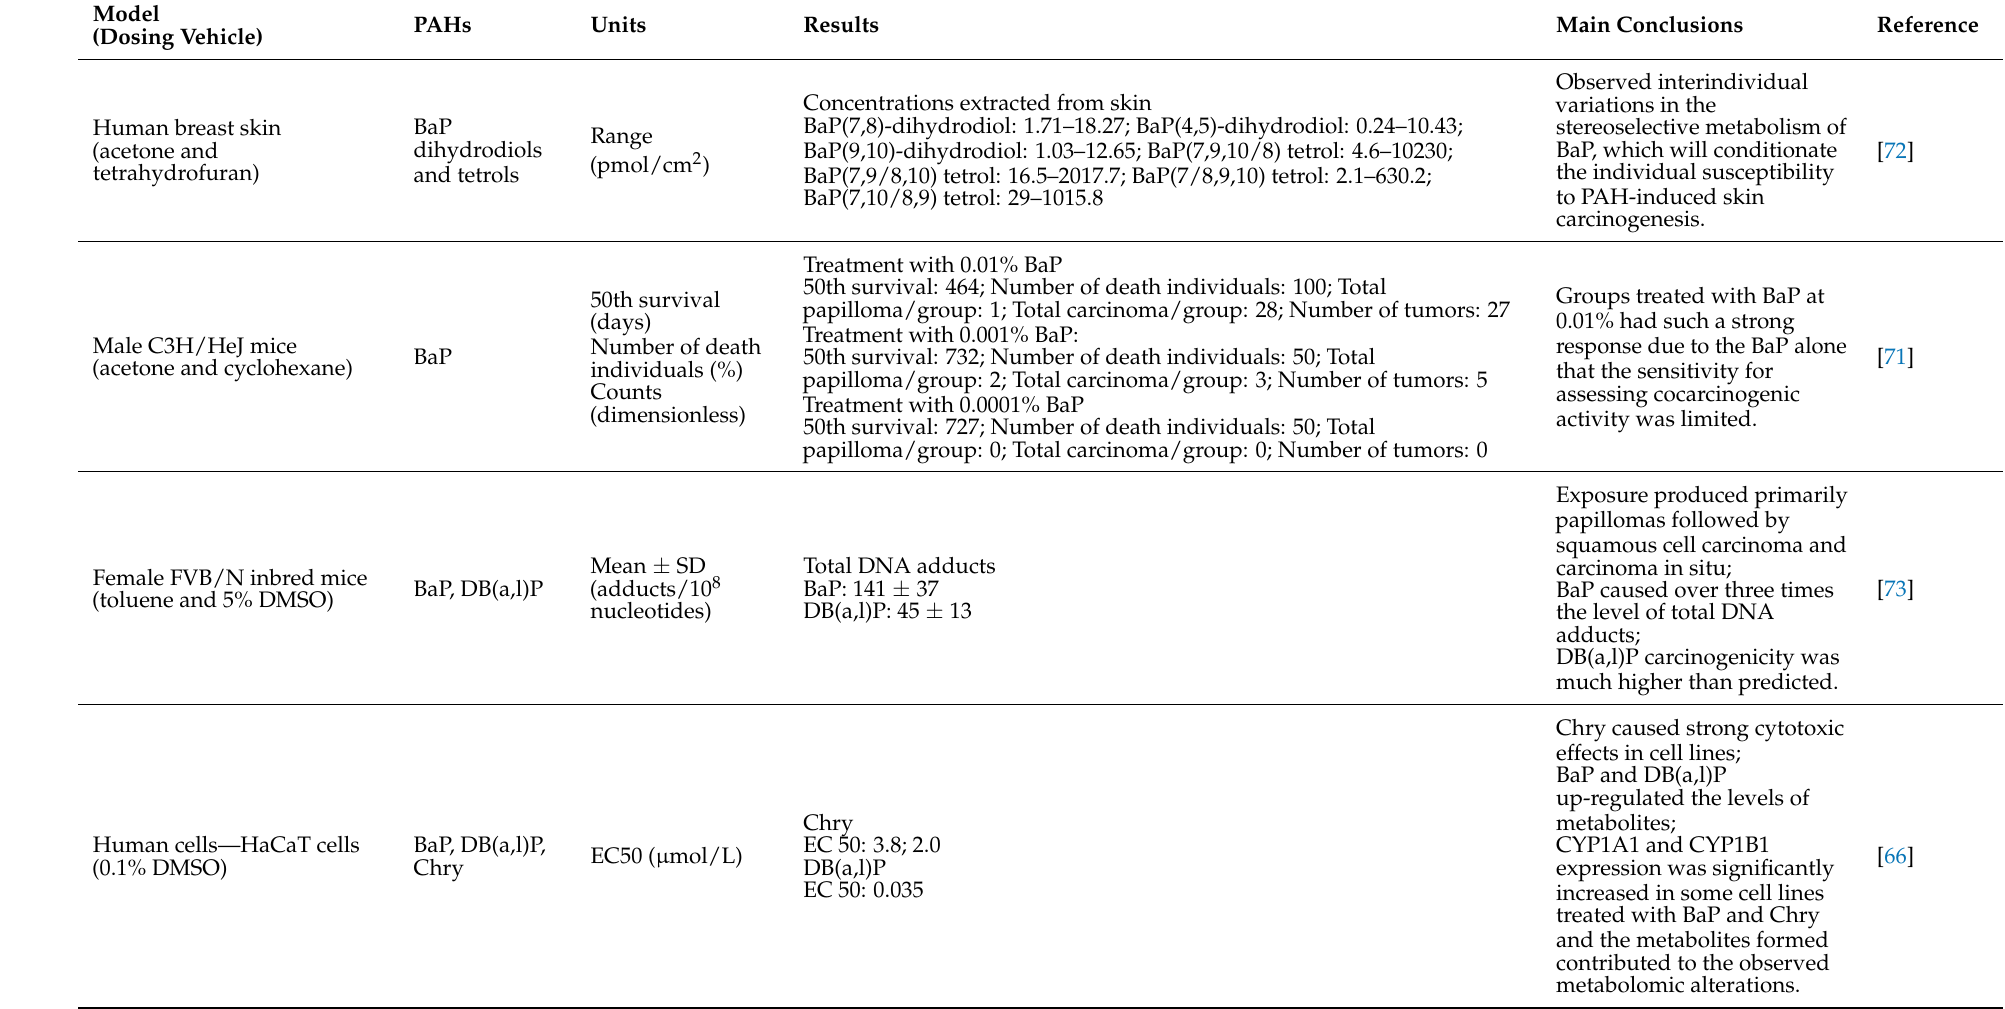
Table 2. Data collected from in vitro/in vivo studies assessing dermal toxicological and carcinogenic risks of